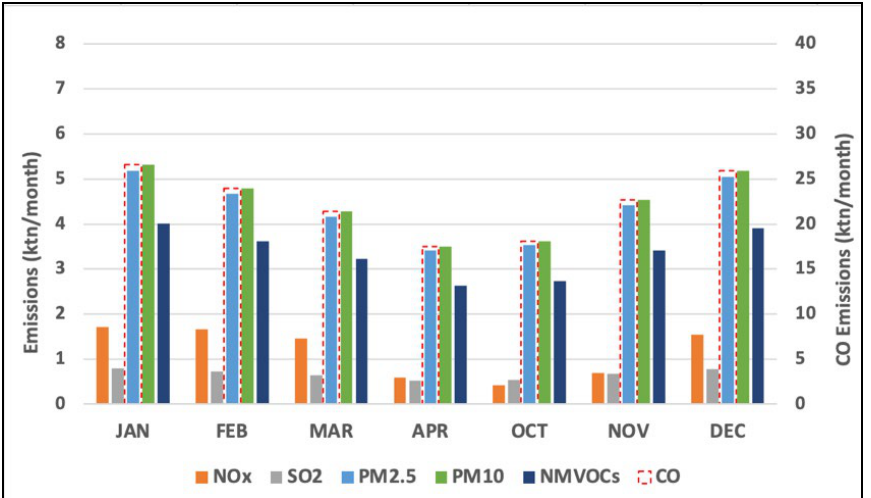
Figure 4 . Monthly variation in total “on-line” heating emissions (in ktn/month) for NO x , SO 2 , ΡΜ2.5, PM10, ΝΜVOCs and CO (secondary axis) over Greece for the cold period of 2015 (January–April, October–December).